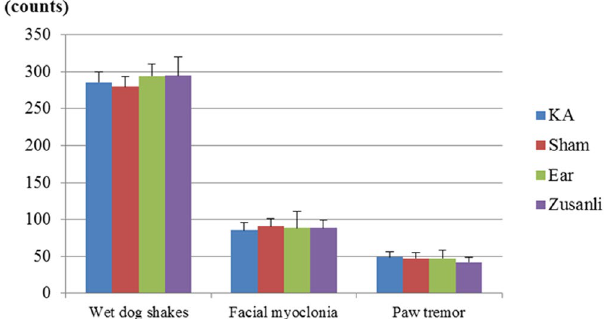
Figure 1. Kainic acid (KA)-induced epileptic seizures in rats. The counts of KA-induced wet-dog shakes, facial myoclonia, and paw tremors were similar among the KA group (KA), sham group (Sham), auricular group (Ear), and Zusanli group